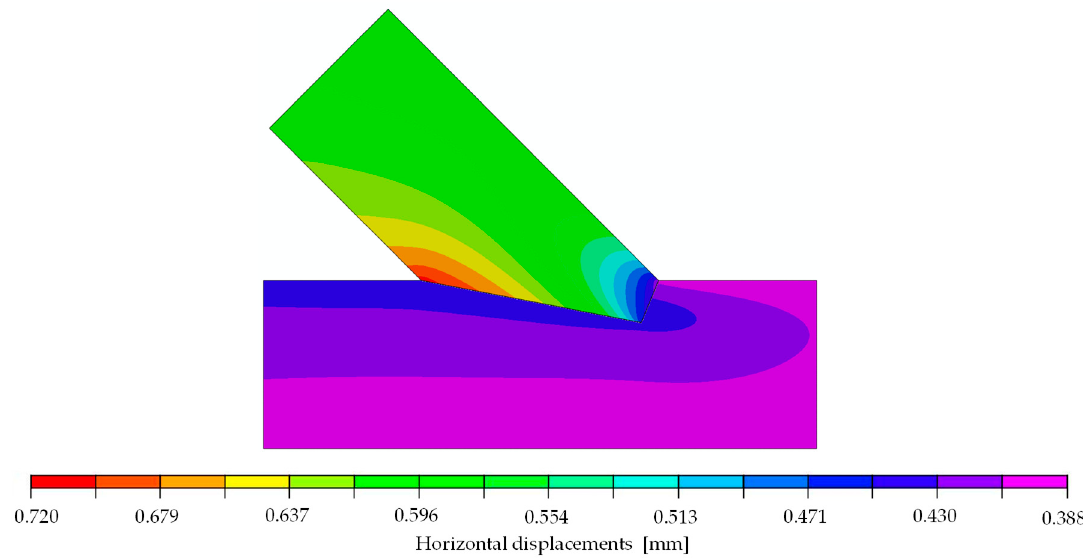
Figure 8. Horizontal displacements of numerical model at 29.6 kN [mm].